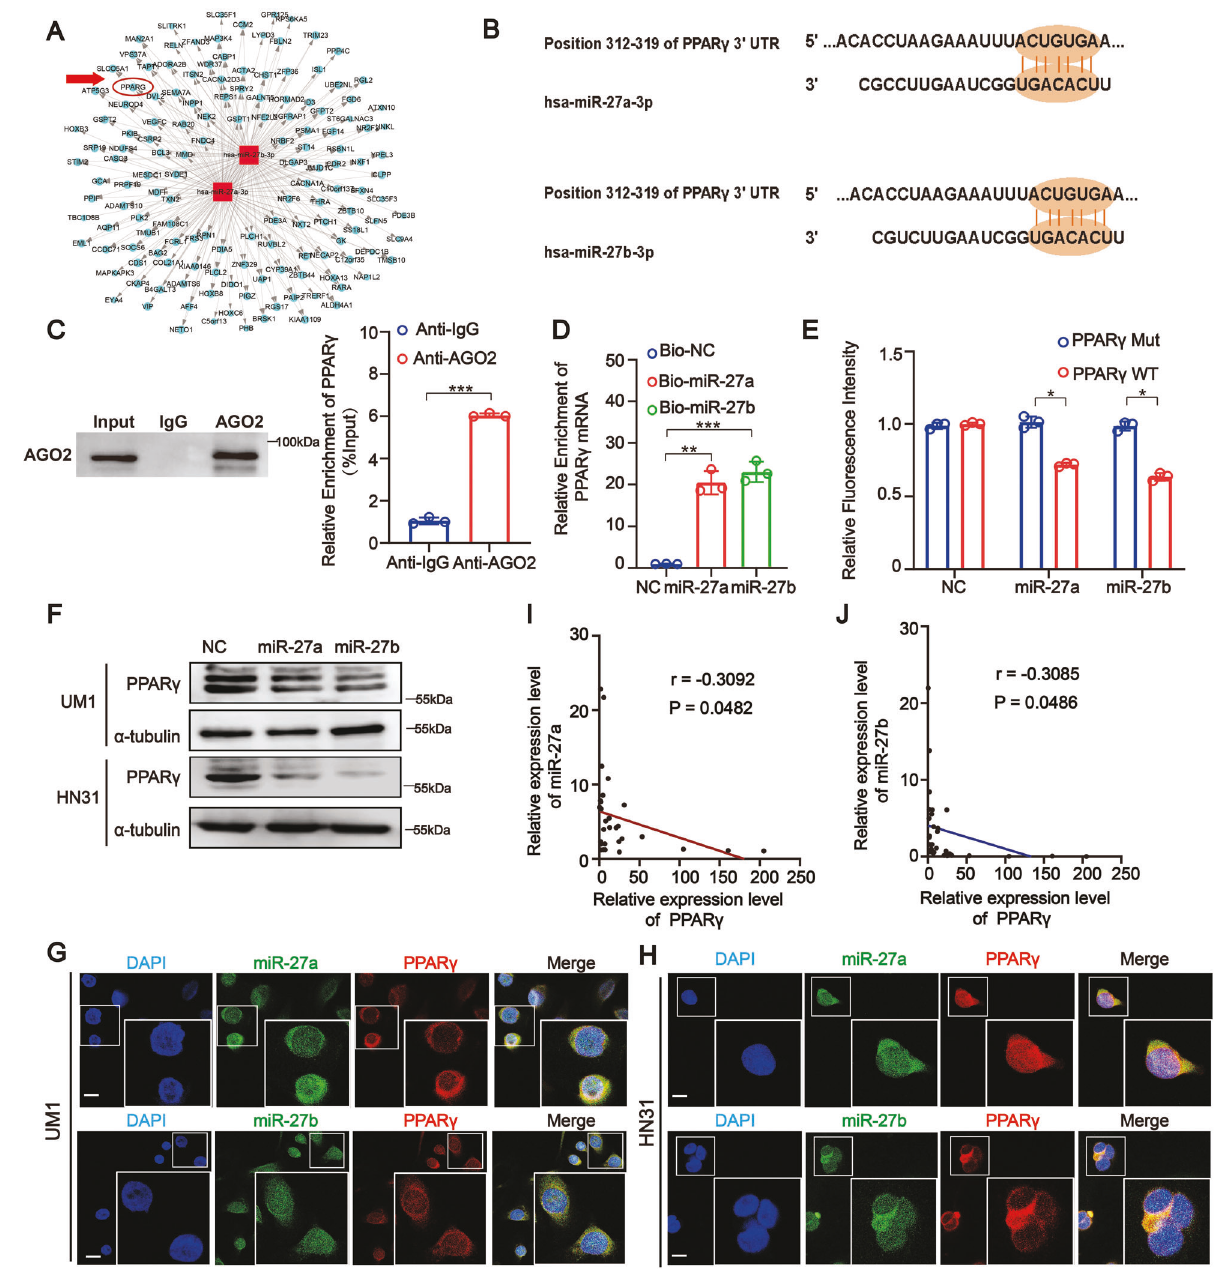
Fig. 5 PPAR γ is a direct target of both miR-27a and miR-27b in HNSCC. A The network of target genes of miR-27a and miR-27b, the red circle represents PPAR γ . B Schematic illustration showed binding site sequences between PPAR γ and miR-27a/27b. C RIP assay showed PPAR γ mRNA was effectively pulled down by AGO2 with a much greater enrichment in UM1 cells. D RNA pull-down assay exhibited for the direct bonding of PPAR γ and miR-27a/27b in UM1 cells. E Dual-luciferase assays were conducted using PPAR γ wild type (WT) and mutant (MUT) 3 ′ UTR reporter constructs to show that the human PPAR γ 3 ′ UTR region contains miR-27a and miR-27b binding sites. (Data were normalized to that with the control probe, showing the mean ± SD of three experiments). F Western Blot assay showed miR-27a and miR-27b mimic could signi fi cantly reduce expression of PPAR γ in UM1 and HN31 cells at the level of proteins. G , H RNA FISH showed colocalization of PPAR γ and miR-27a/27b in UM1 and HN31 cells (Scale bar, 10 μ m). I , J Pearson correlation analysis indicated miR-27a and miR-27b expression was negatively correlated with PPAR γ expression in patients with HNSCC ( n = 15 and 15, respectively). Data were shown as the mean value ± SD of three independent experiments. The asterisks indicate signi fi cant differences (Student ’ s t -tests, * P < 0.05, ** P < 0.01, *** P < 0.001). expression in saliva, blood, and extracellular vesicles. Increasing targets. Here, we discovered a novel mechanism in HNSCC amounts of circRNAs have been detected and their biogenesis, metastasis: circRFWD3 could sponge miR-27a/b to promote characteristics, and functions have been explored in a variety of metastasis by augmenting PPAR γ /NF- κ B/MMP13 signaling (Fig. 7G). cancers [23, 24]. To date, despite rapid advances in studies CircRNAs, as a new type of noncoding RNAs, mainly have based on circRNAs, little is known about the explicit roles of several characteristics: species conservation, unique circular circRNAs in HNSCC, especially in the development and and stable structures, cell and tissue speci fi city, and stable Cell Death Discovery (2022)